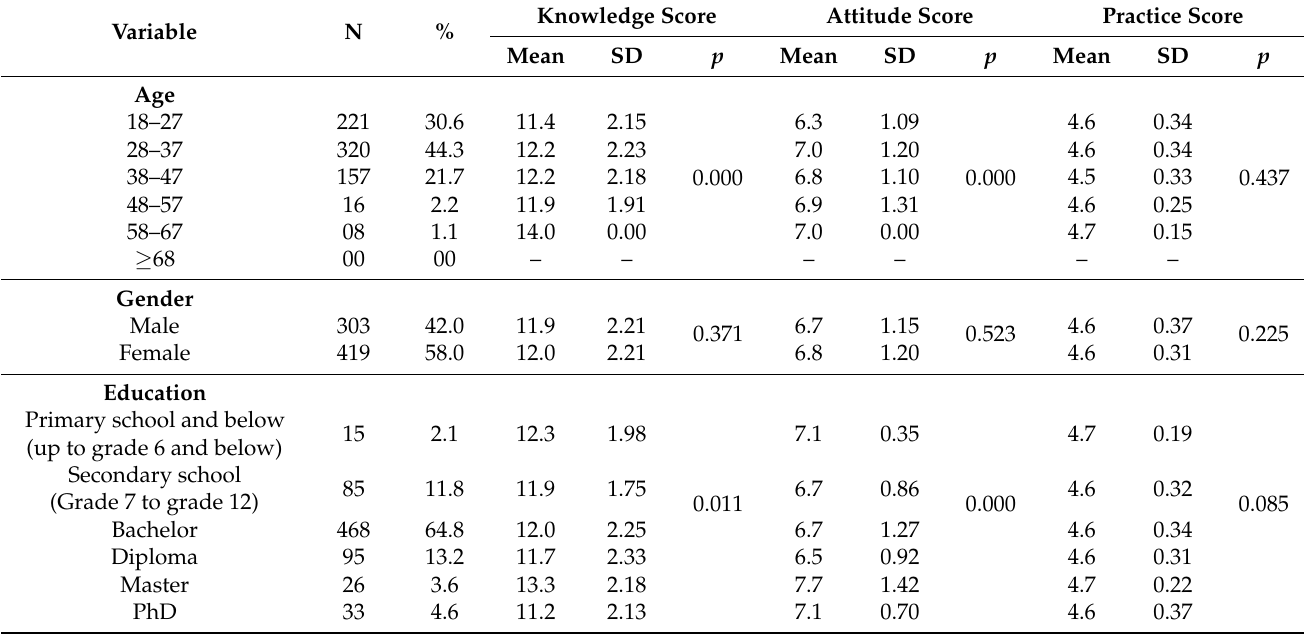
Table 6. Comparison of the mean KAP score and demographic